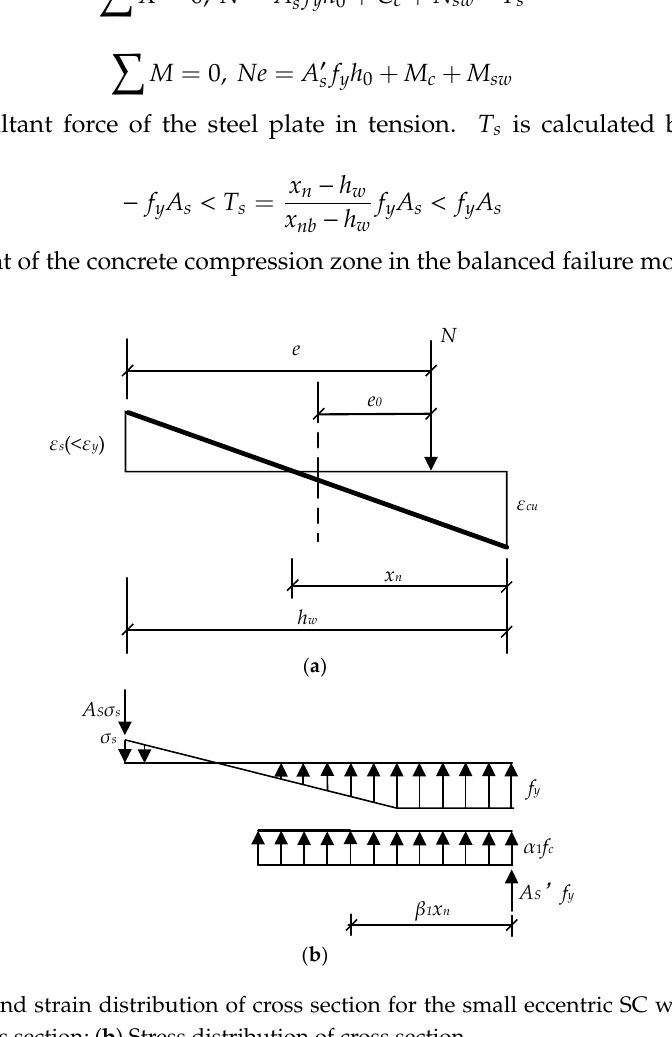
Figure 11. Equivalence of web plate for the small eccentric SC wall.